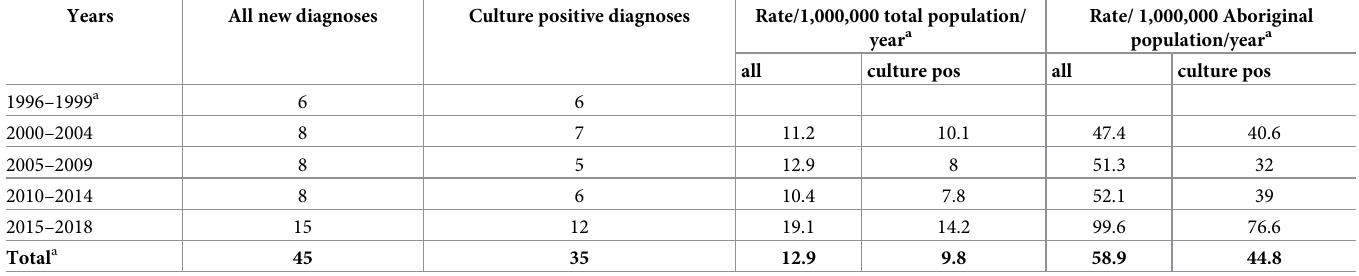
a Not all regions had estimates available for the first 4 years of the study. Where this was the case, data from the next available census was used for the purposes of calculating incidence of the entire study.